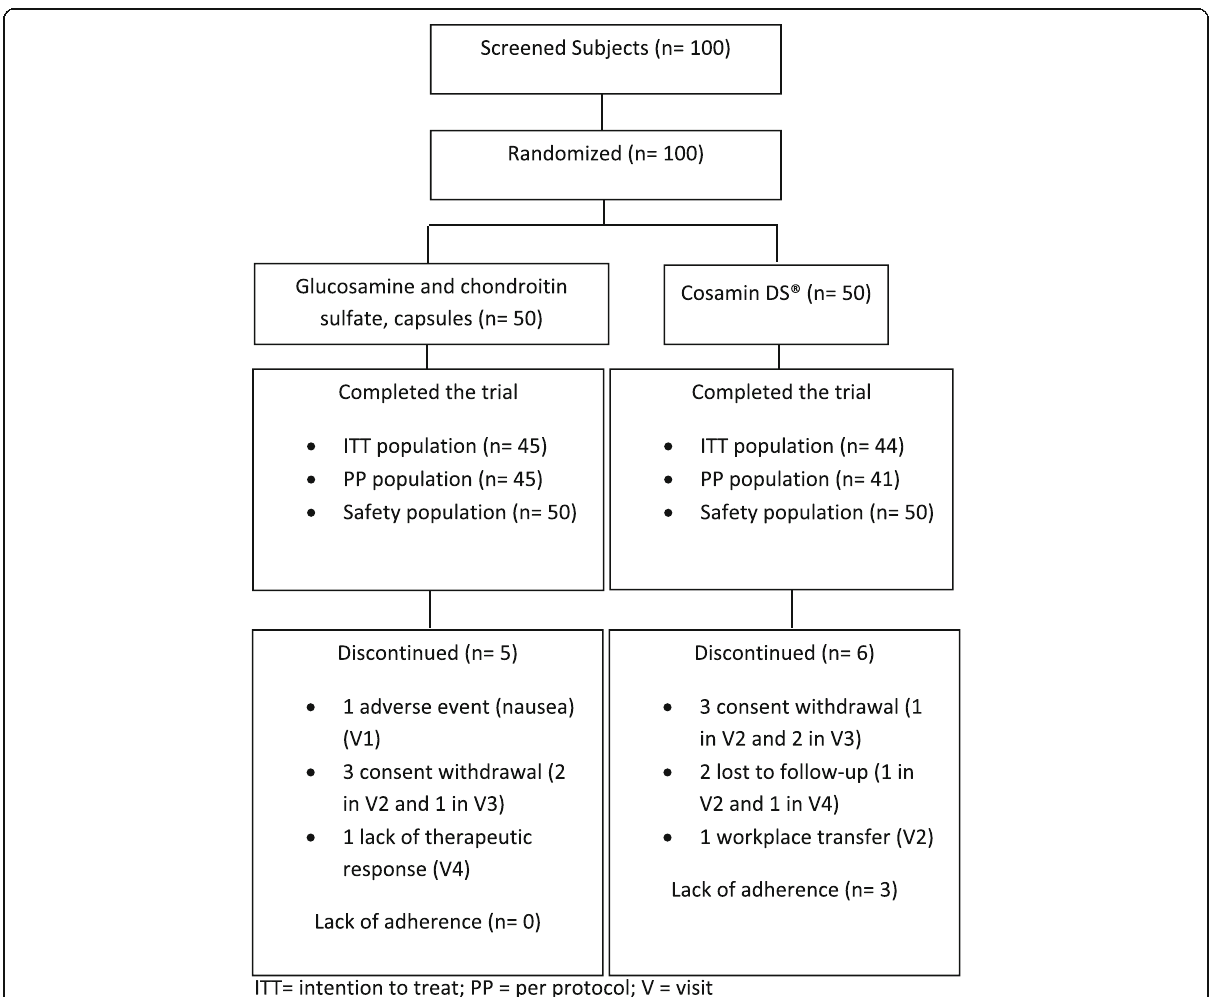
Fig. 1 Trial subjects flowchart. ITT intention to treat, PP per protocol, V